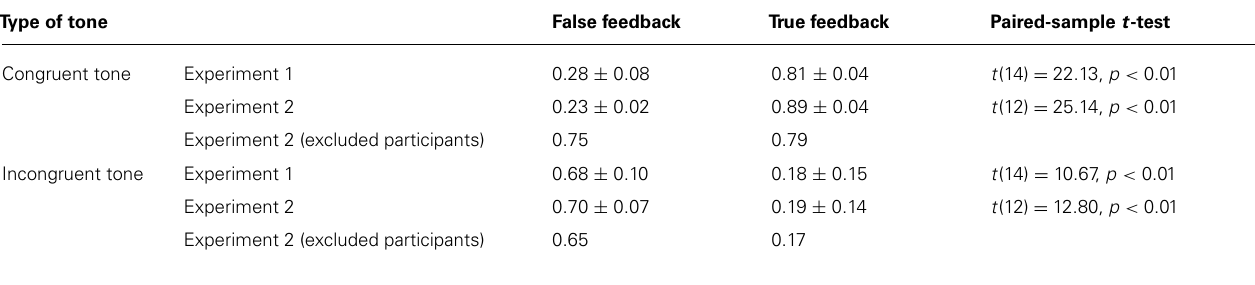
Table 3 | Mean ± SD self-agency rating in different conditions of Experiment 1 and